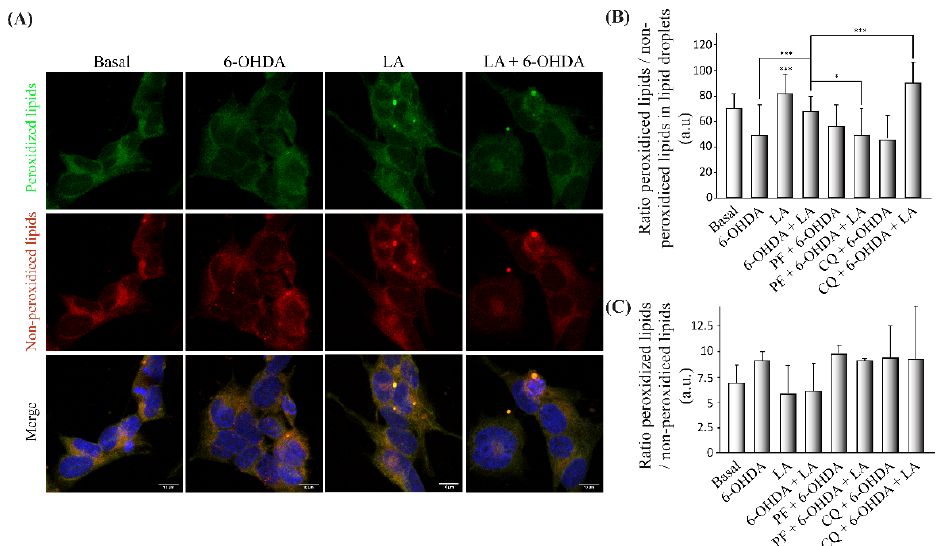
Figure 6. Regulation of lipid peroxidation by LA in the SH-SY5Y PD model. ( A ) Representative maximum intensity projection of confocal images showing the immunocytochemical assay with the BODIPY 581/591 C11 marker. Peroxidized lipids are shown in green, and nonperoxidized lipids are shown in red on cells treated or not with LA and 6-OHDA. ( B ) Quantification of the peroxidized lipids/nonperoxidized ratio in the LDs of the different experimental groups. The mean ± SD of 6 experiments per group is shown. Data were analyzed using one-way analysis of variance (ANOVA) followed by a multiple comparison test with Bonferroni. *** p < 0.001; * p < 0.05 (if not indicated, it is for the control). ( C ) Determination of the BODIPY 581/591 C11 signal by flow cytometry on the SH-SY5Y cell line treated or not with LA, PF, CQ, and/or 6-OHDA. The graph shows the mean of the peroxidized/nonperoxidized lipids ratio obtained from the BODIPY 581/591 c11 signals of the different treatment groups. The results correspond to the mean ± SD of 4 independent experiments per group. Data were analyzed by one-way analysis of variance (ANOVA), followed by the Games–Howell correction.